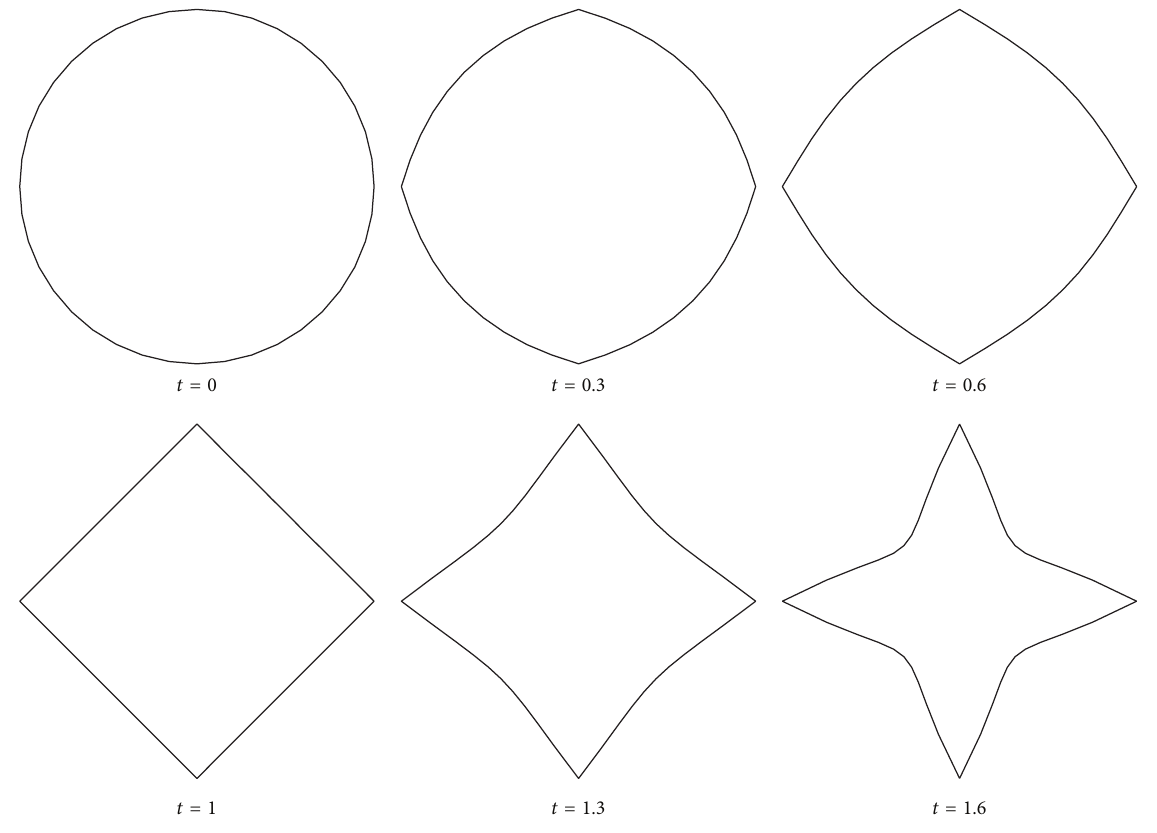
Figure 3: Blended shapes with different 𝑡 values.